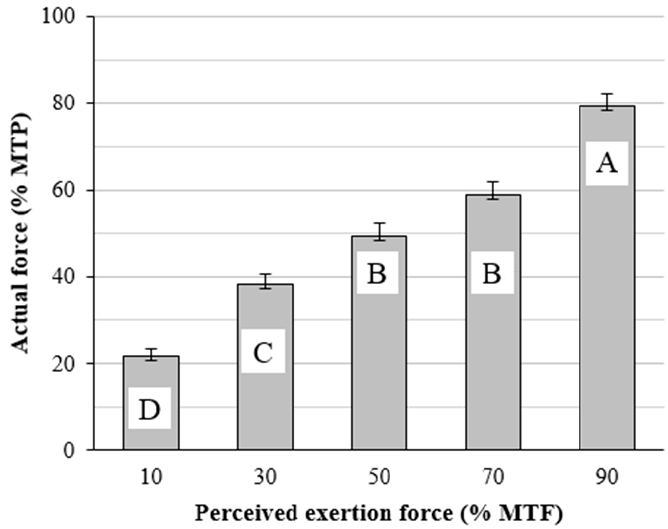
Figure 3. Actual exerted % MTF according to perceived exertion level (% MTFs). MTF denotes maximum thumb force. Alphabetic letters denote statistically significant groupings, p = 0.05. Table 2. Comparison between actual and perceived exertion level (%